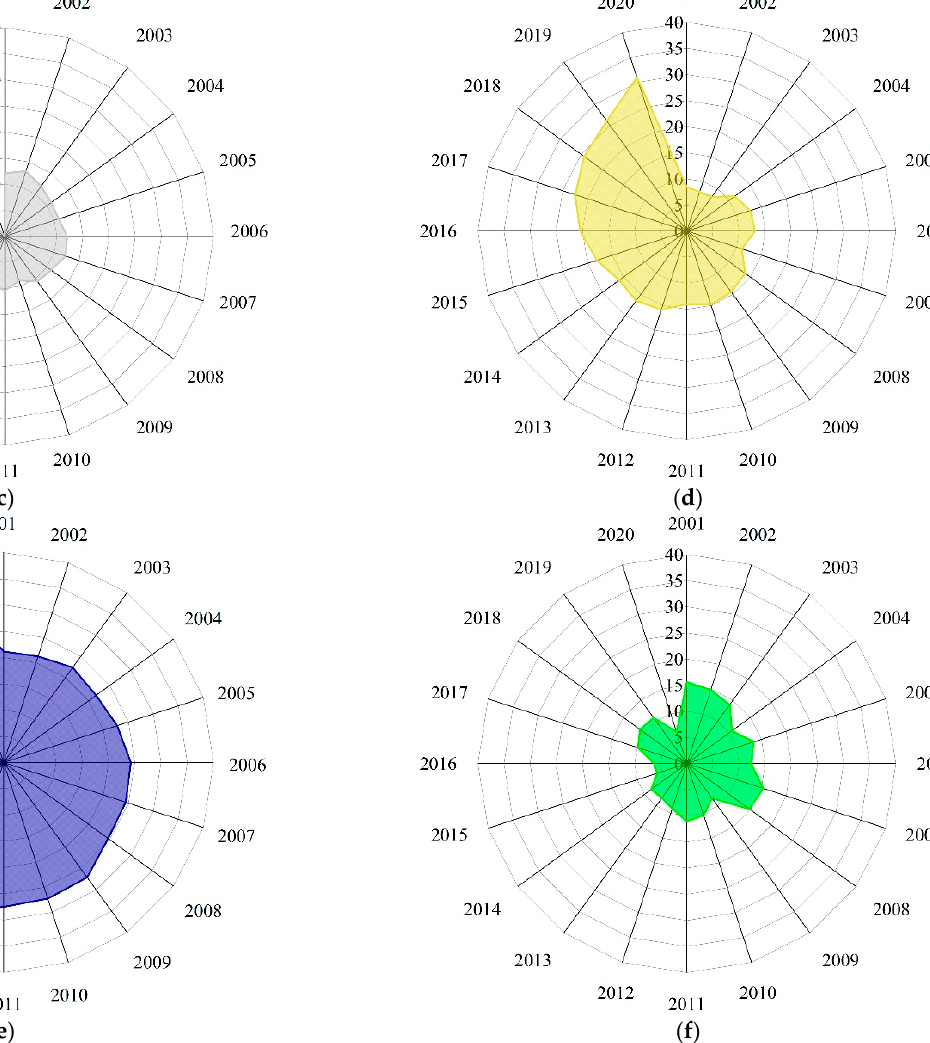
Figure 2. Radar chart of the obstacle degree of each unit from 2001 to 2020. ( a ) Availability, ( b ) distribution, ( c ) utilization, ( d ) vulnerability, ( e ) sustainability and ( f ) regulation.